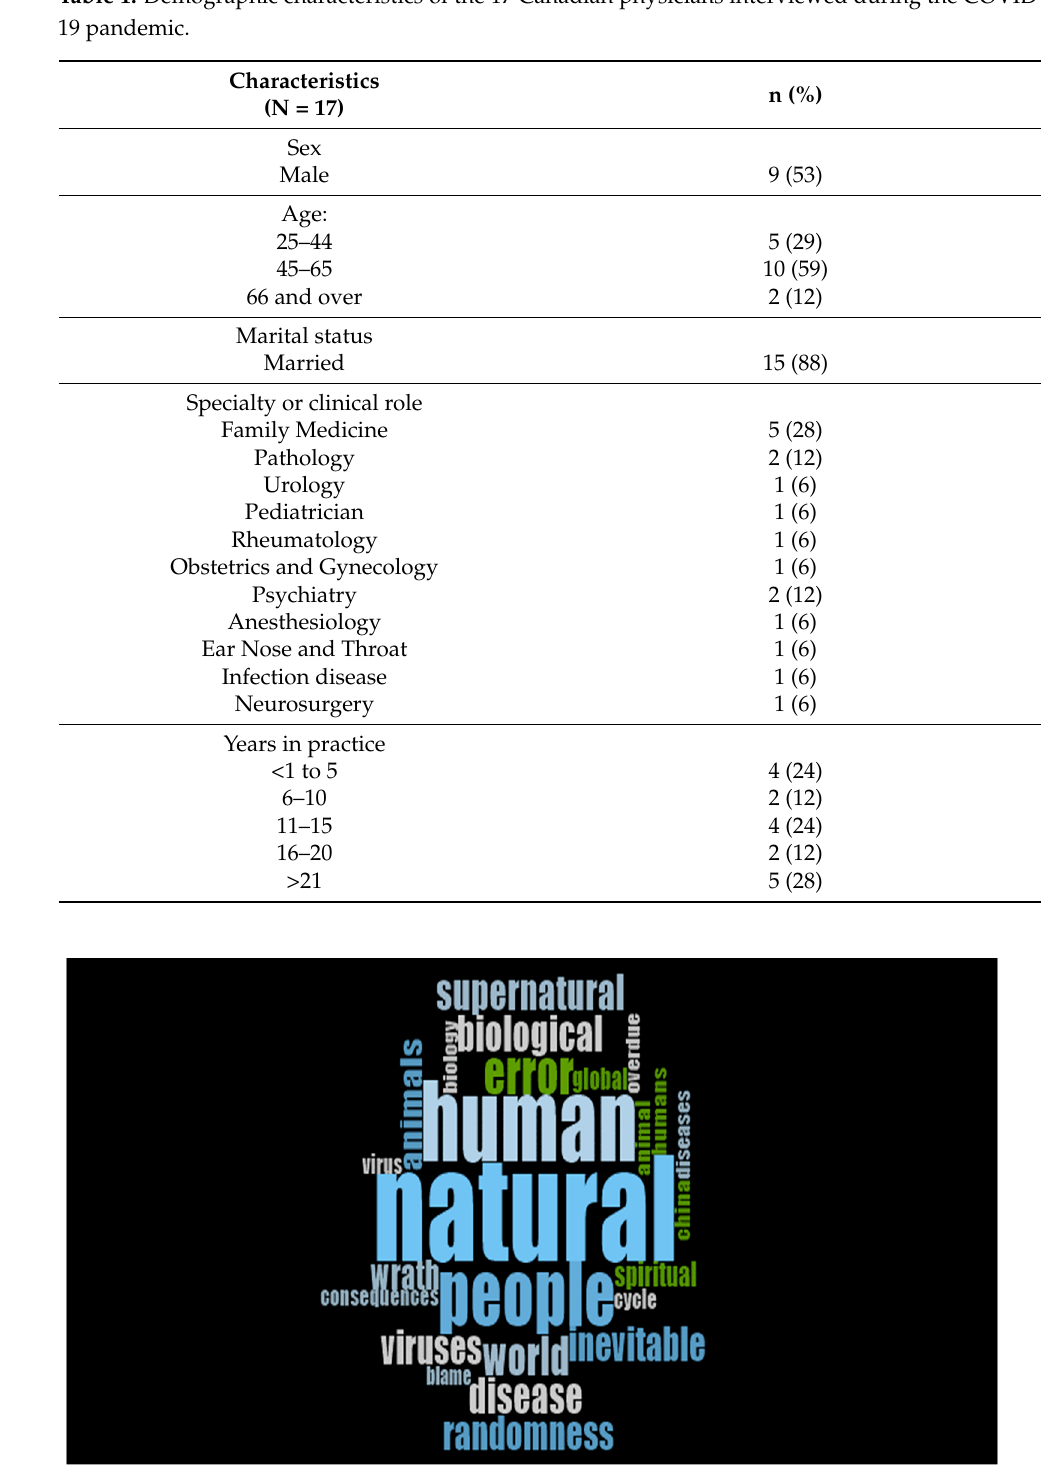
Figure 1. Word cloud depicting physicians’ views about the origin of the